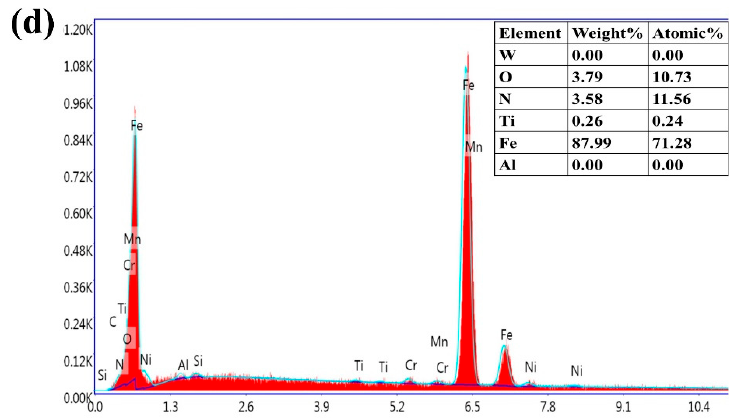
Figure 11. EDS analysis at v c = 440 m/min, f z = 0.04 mm/z, a p = 0.4 mm, and a e = 4 mm. ( a ) Area A in Figure 10a. ( b ) Area B in Figure 10b. ( c ) Area C in Figure 10c. ( d ) Area D in Figure 10d.